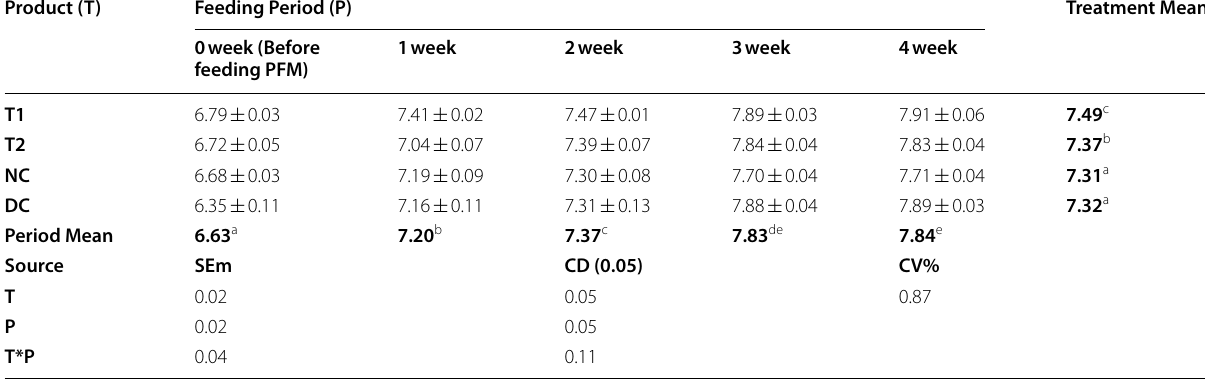
Table 5 Evaluation of Streptococcal count (log cfu/ml) of fecal matter